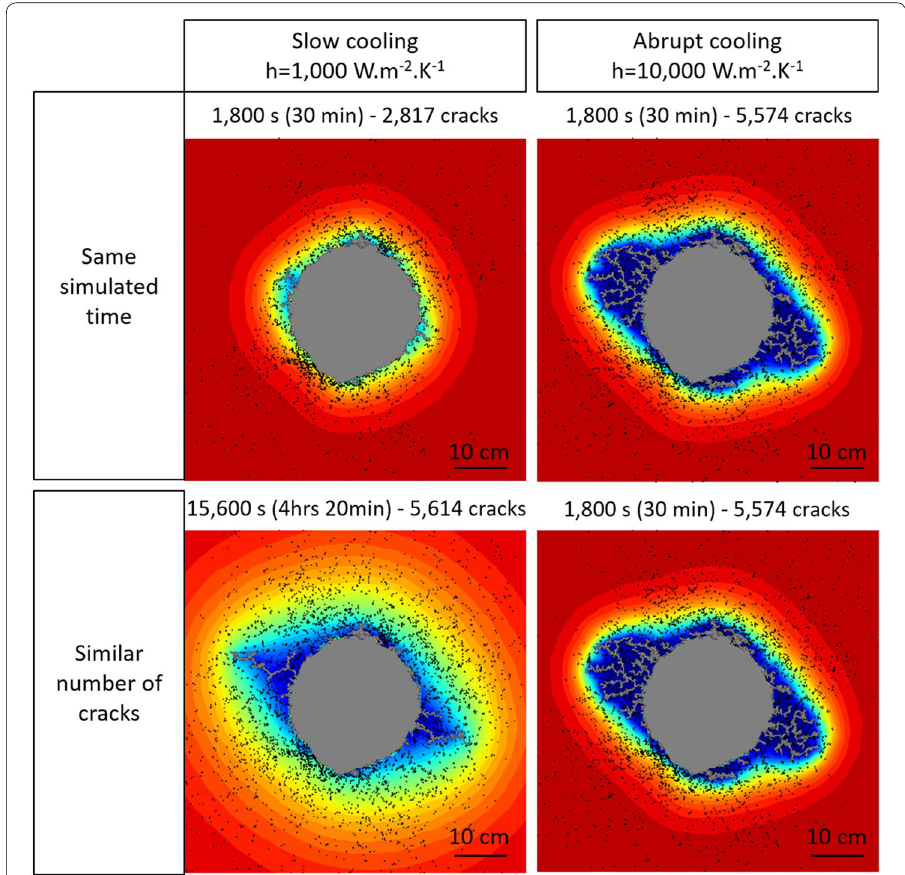
Fig. 16 Influence of the heat transfer coefficient on the temperature field and on crack apparition (legend: colormap is the same as in Fig. 15), for a stress state corresponding to case C (defined in "Numerical approach" section), with no hydraulic loading. Results on left correspond to a low heat transfer coefficient (1000 W m − 2 K − 1 ). Results on right correspond to a high heat transfer coefficient (10,000 W m − 2 K − 1 ). On the · top line, the comparison is made for the same duration of cool fluid injection (half‑hour). On the bottom line, the comparison is made for a similar number of cracks (and different cooling